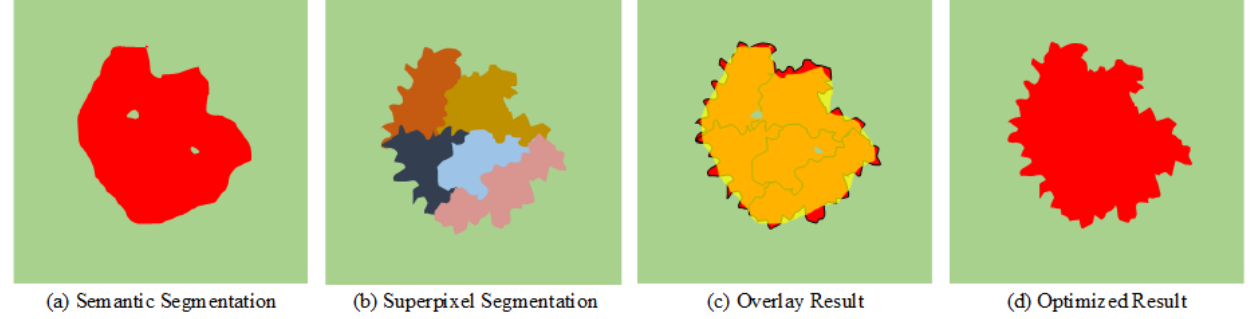
Figure 7. Schematic diagram of optimizing semantic segmentation results by superpixel segmentation result. ( a ) The result of the semantic segmentation. ( b ) The result of the superpixel segmentation. ( c ) The overlay result (yellow represents the esult of the semantic segmentation, red represents the result of the superpixel segmentation). ( d ) The optimized result of semantic